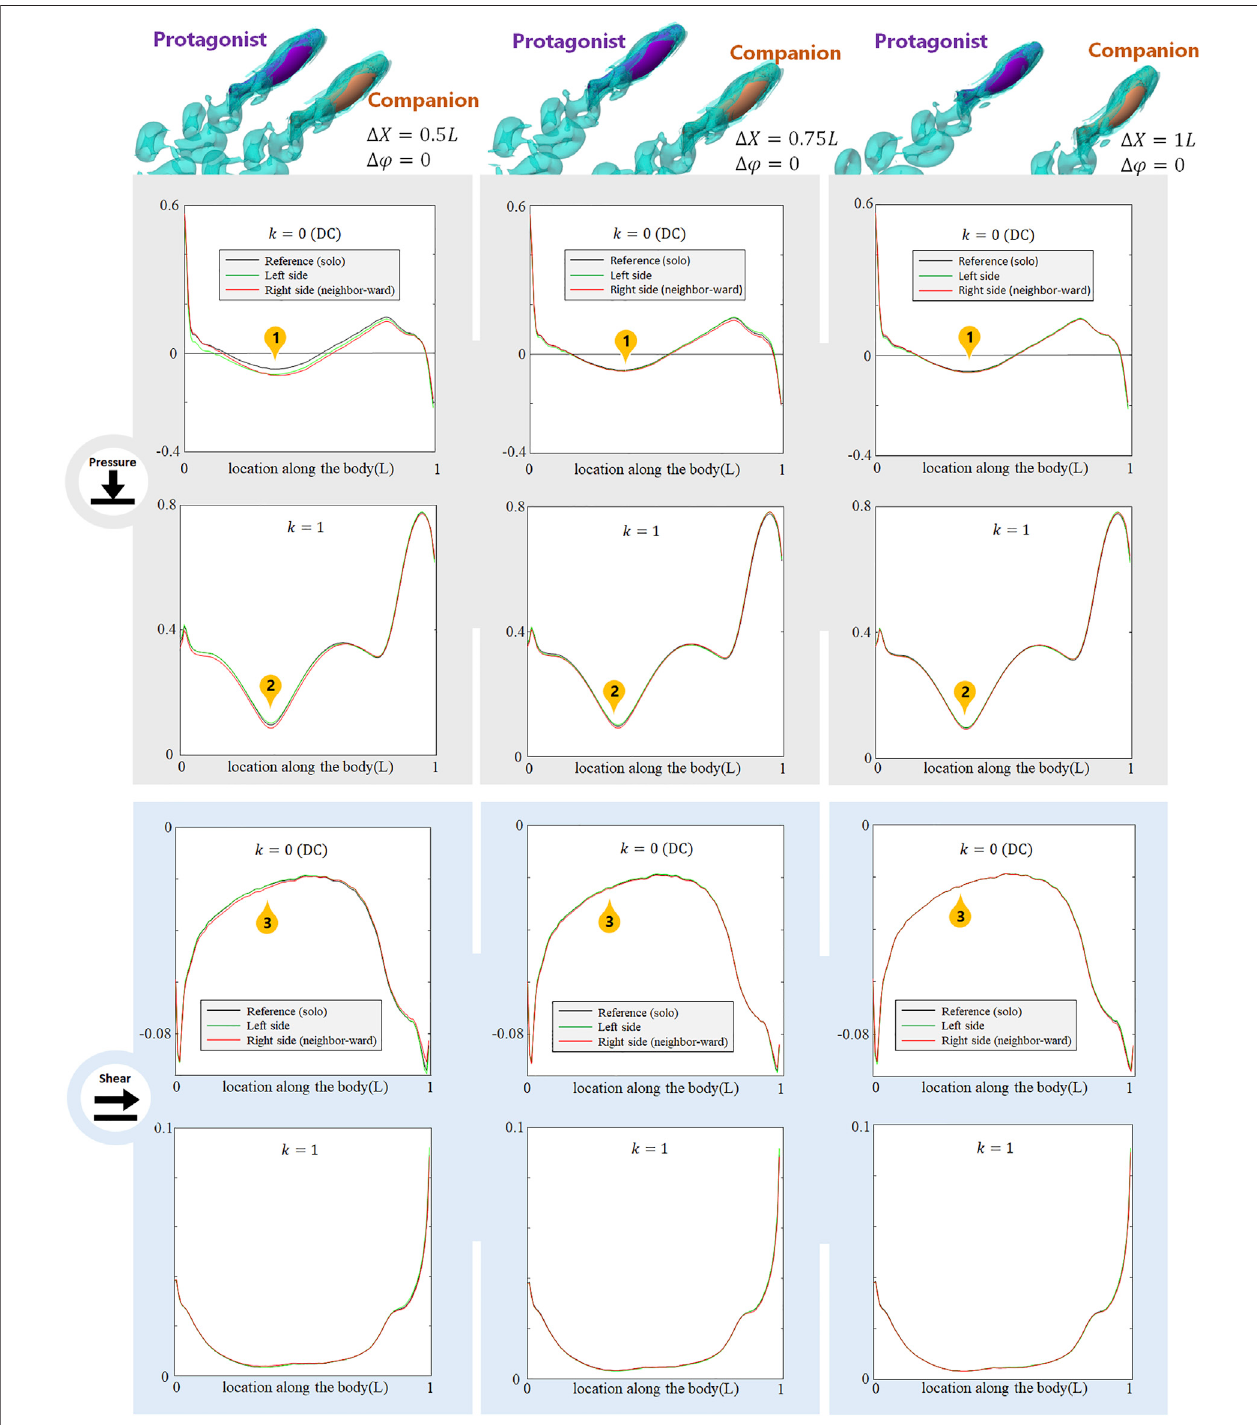
FIGURE 4 | Signal features sensed by the protagonist fi sh when an alongside, in-phase neighbor is 0.5 L,0.75 and 1 L away on its right side. Full results are presented in Supplementary Figures S2-S4 , ESM. One stress unit = 10 Pa.